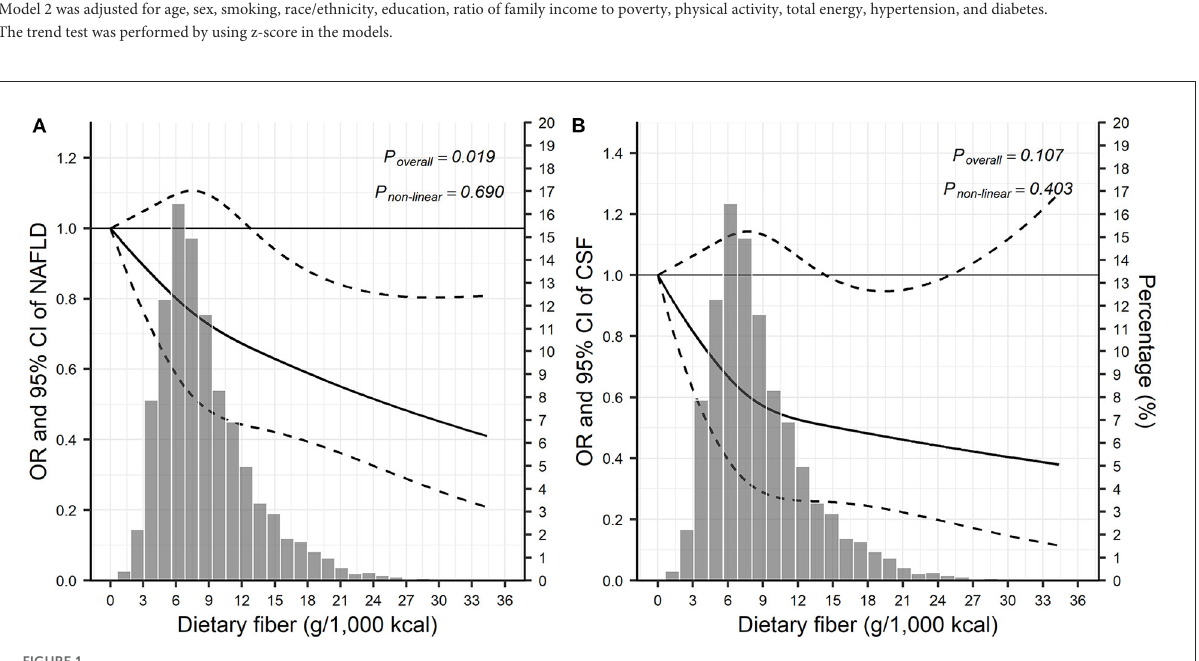
number of CSF, we did not observe a statistically significant association between dietary fiber and